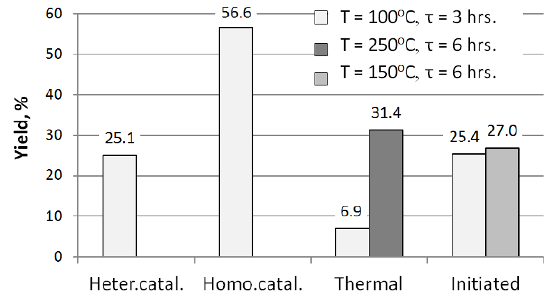
Figure 1. Yield of the cooligomers synthesized by different methods.